Question: Based on the figure, does the quantity rise or fall?
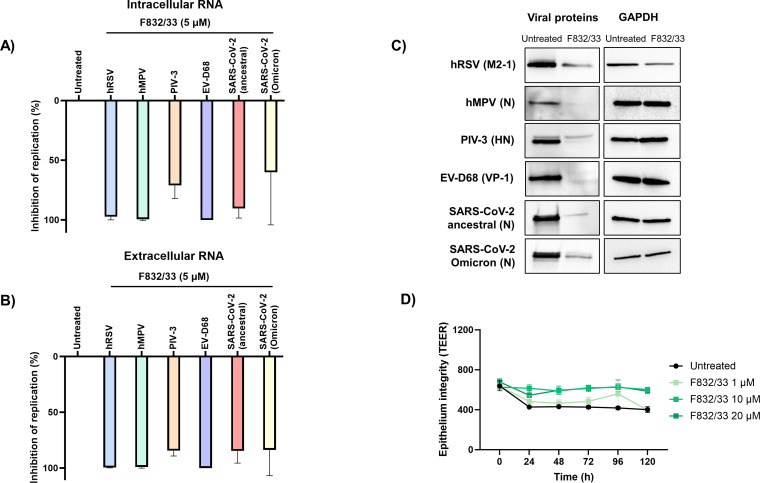
Answer: increasing